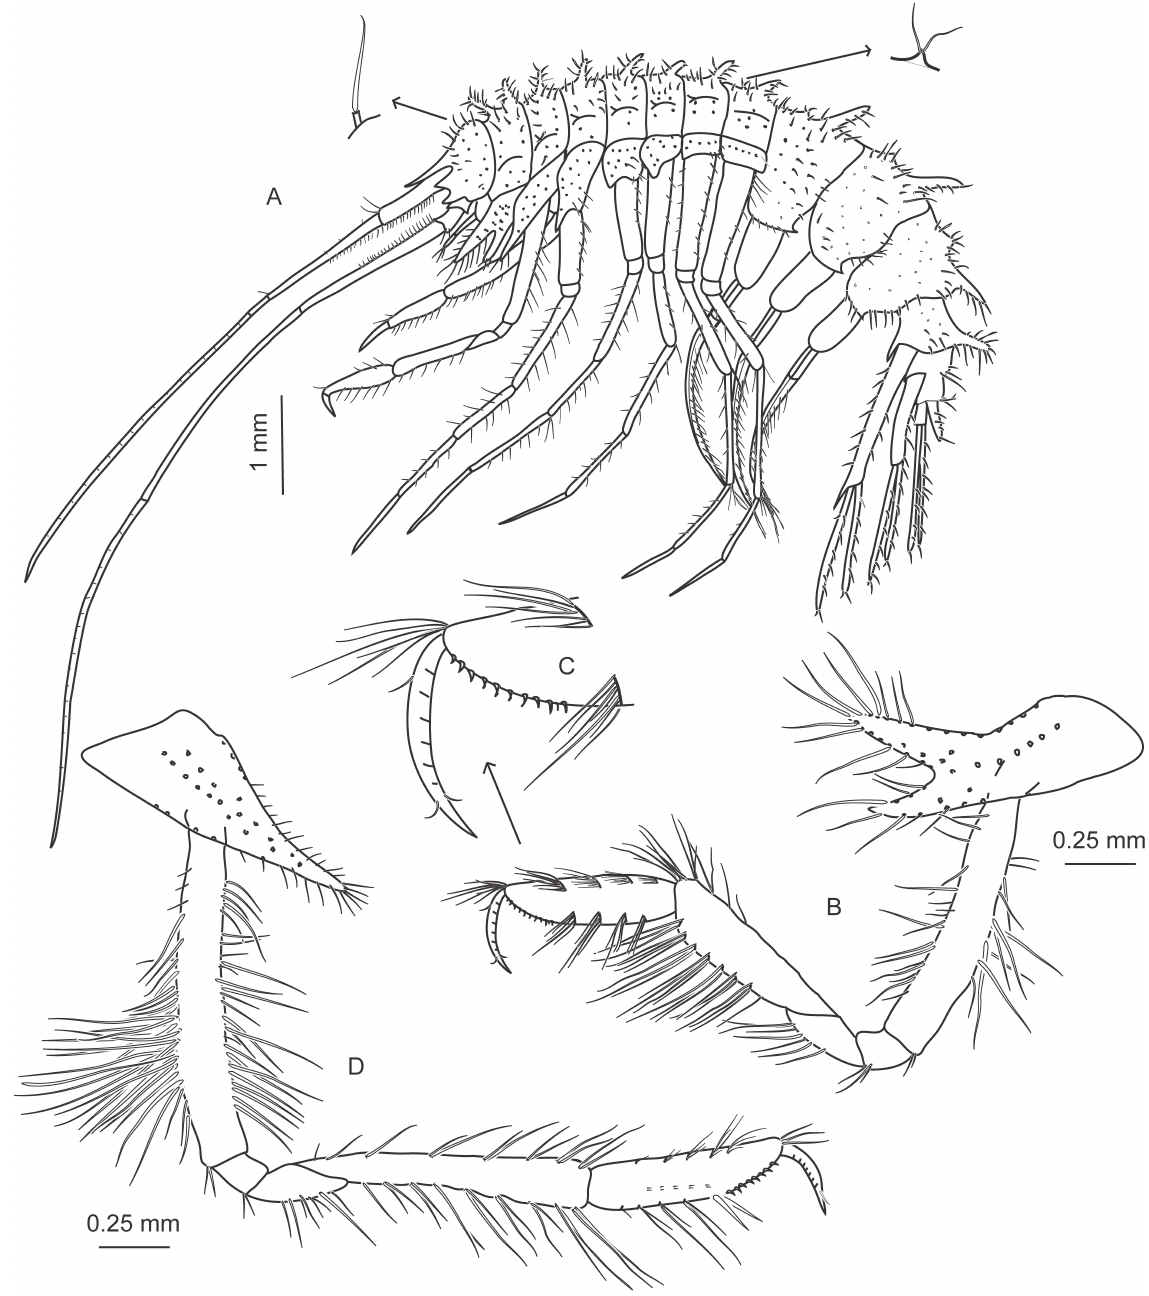
Fig. 5. Lepechinella norvegica sp. nov., holotype, ♂. A . Habitus. B . Left Gn1. C . Dactyl and propodus of Gn1. D .